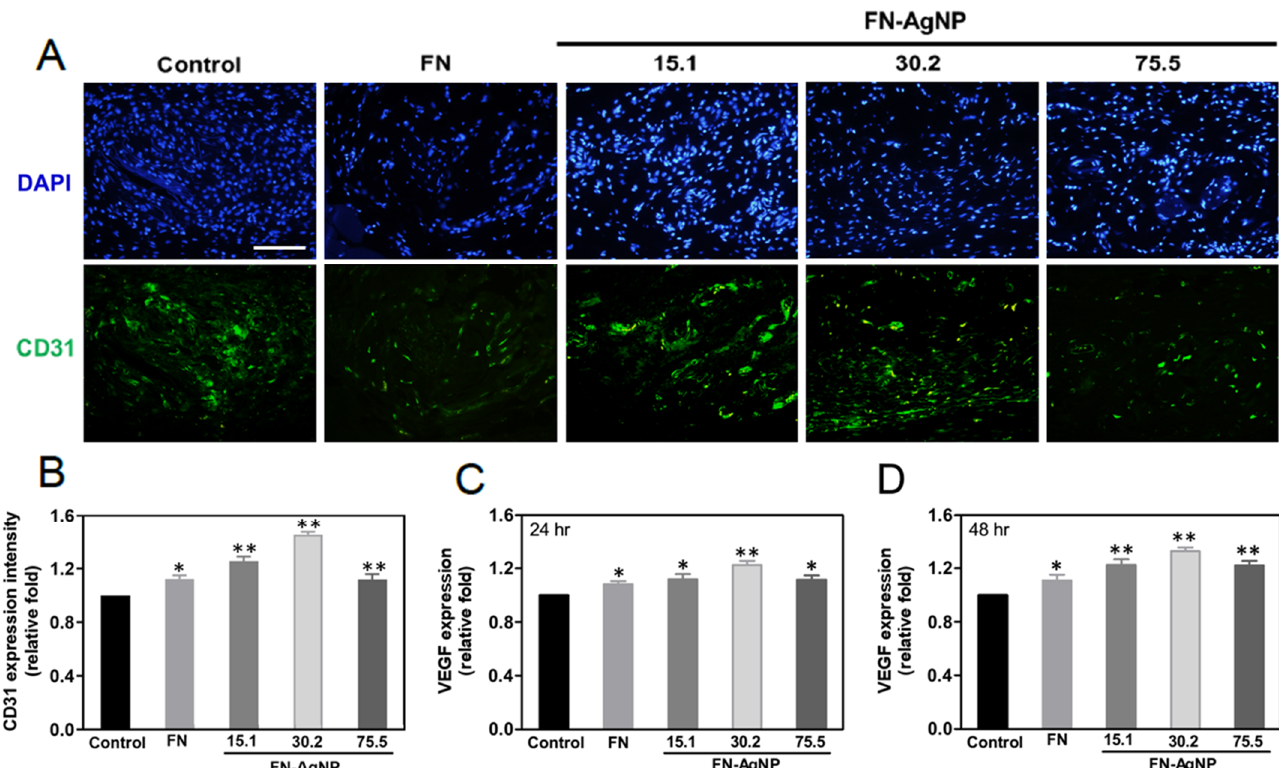
Figure 7. Immunohistochemistry staining for endothelialization marker CD31 affected by the implant materials. ( A ) The histology images for CD31 were showed after implanting various materials for 4 weeks. Scale bar = 100 μm. ( B ) The CD31 expression was also investigated and then semi-quantified according to fluorescence intensity. * p < 0.05; ** p < 0.01: higher than the control ( n = 5). ( C – D ) The expression level of VEGF protein was evaluated via ELISA assay at 24 and 48 hours, then the fluorescence intensity were semi-quantified by Image J software. Data are the mean ± SD. * p < 0.05; ** p < 0.01: greater than the control ( n = 5).